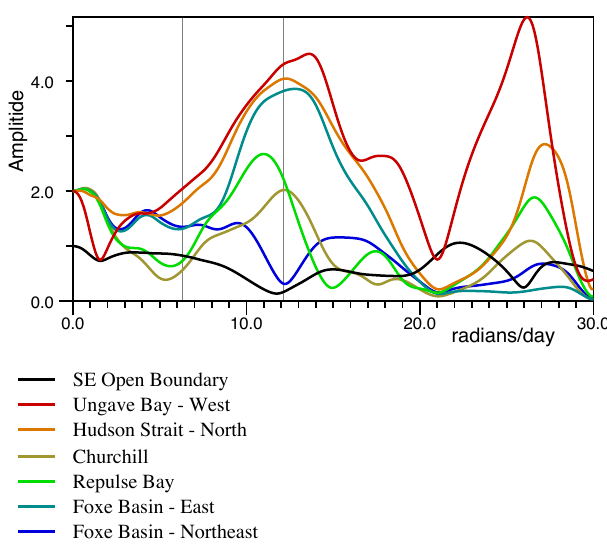
Figure 3. In colour: amplitude of the response function plotted as a function of angular velocity for real values of angular veloc- ity. Colours: red, Ungava Bay (Hopes Advance Bay); orange, loca- tion R2 (see Fig. 1), north side of Hudson Strait; brown: Churchill; green, Repulse Bay; light blue, R3, East Foxe Basin; dark blue, R4, North Foxe Basin. In black: amplitude of outgoing (radiated) wave at boundary point